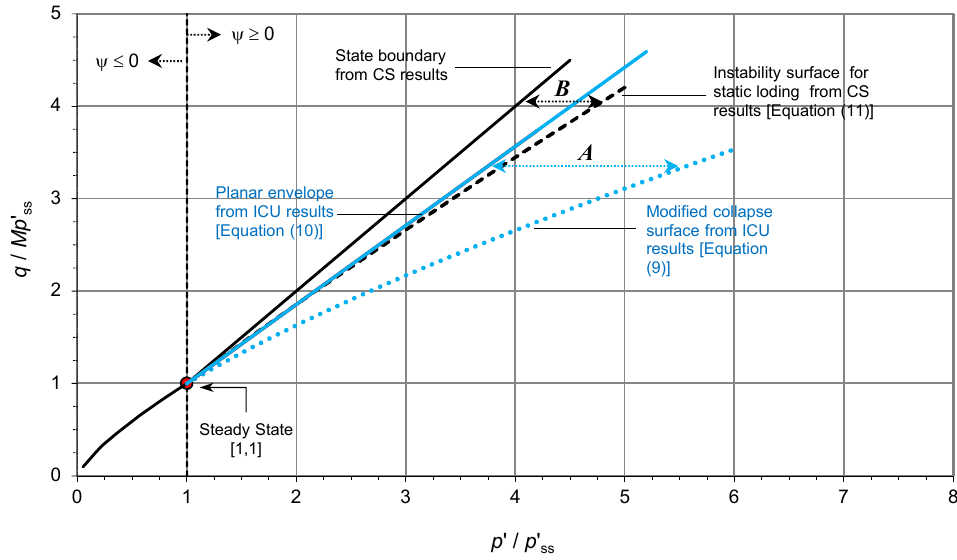
Figure 15. Comparison of the instability regions from the ICU and CS results. The modified collapse surface defined by the peak states of undrained loading (Equation (9)) and the instability surface for static loading (Equation (11)) can be repre- sented in a same form,